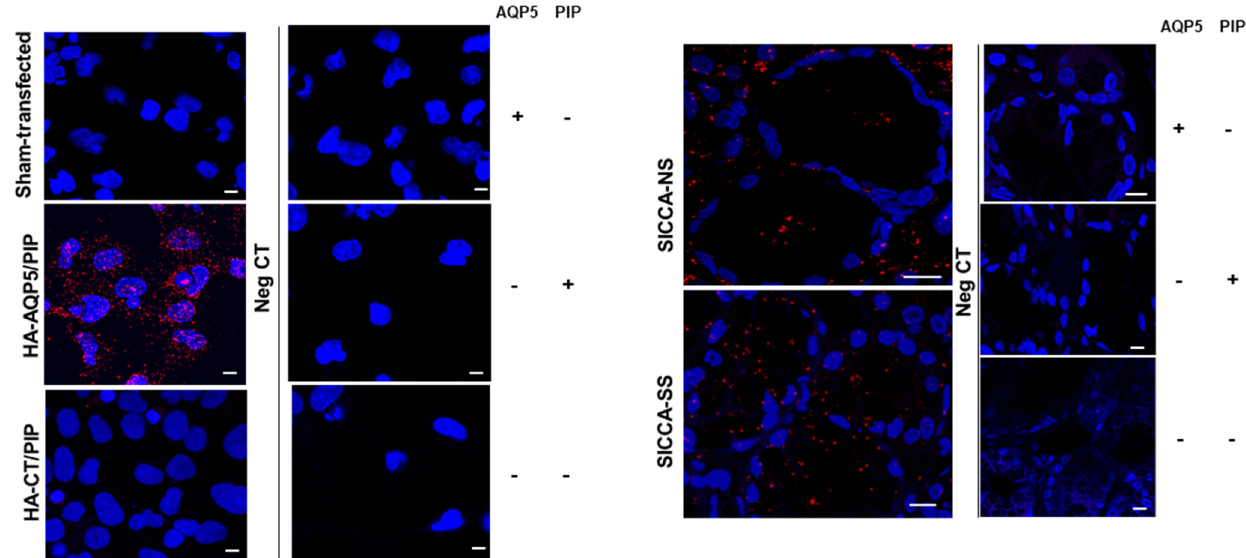
Figure A1. Protein-protein interactions in transfected NS-SV-AC cells and hMSG. Protein-protein interactions visual- ized as red fluorescent spots on transfected NS-SV-AC ( left ) and hMSG ( right ). Nuclei were labelled with DAPI (blue). Left , negative controls were performed using NS-SV-AC transfected with HA-AQP5 and PIP in the absence of anti-HA antibody, anti-PIP or both primary antibodies. Right , negative controls were performed using hMSG from SICCA-NS in the absence of anti-AQP5 antibody, anti-PIP or both primary antibodies. Scale bar, 10 µm.